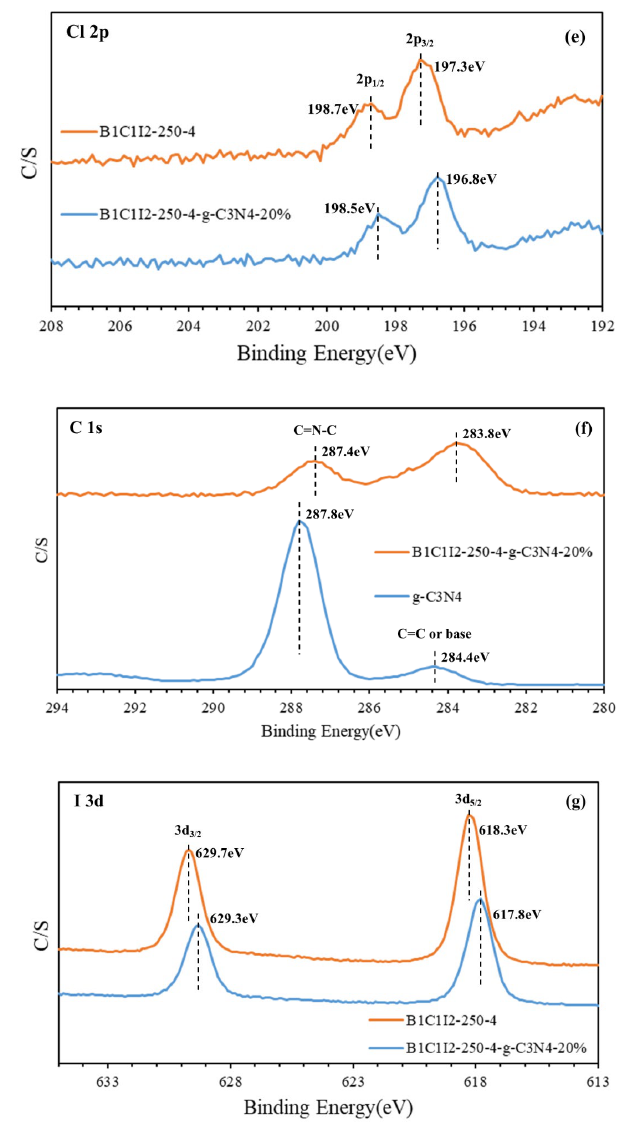
Figure 3. High-resolution X-ray photoelectron spectroscopy spectra of the BiOmCln/BiOpIq/g-C3N4- 20% photocatalyst prepared under a KCl:KI molar ratio of 1:2, a hydrothermal temperature of 250 °C, a pH of 4: ( a ) complete survey, ( b ) Bi-4f, ( c ) O-1s, ( d ) N-1s, ( e ) Cl-2p, ( f ) C-1s, and ( g ) I-3d spectra.